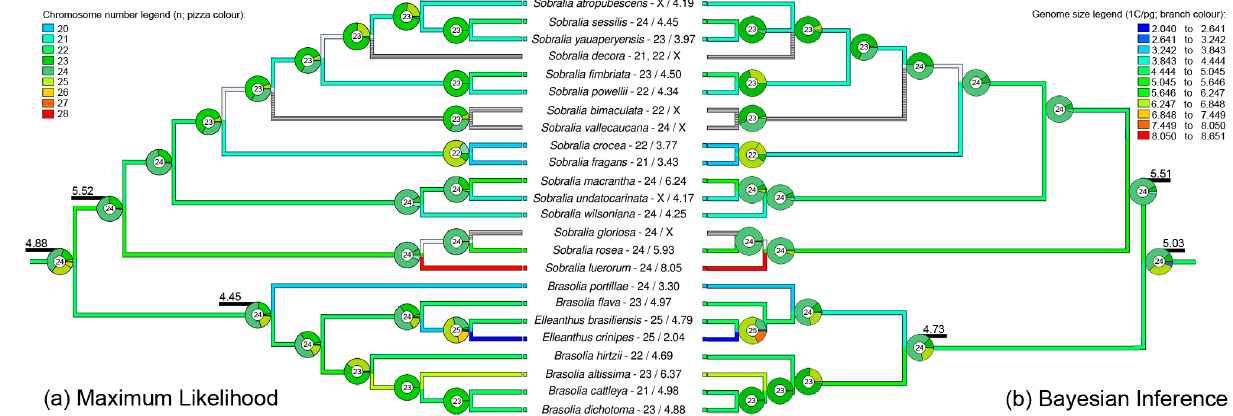
Figure 2. Maximum likelihood ( a ) and Bayesian Inference ( b ) pruned phylogenies showing the ancestral reconstruction of base chromosome number on nodes and genome size (1C-value) on branches. The ancestral genome size is indicated on the node for Brasolia , Sobralia , and the ancestral of both genera. The colour legend for the base chromosome number is on the right, and for genome size, on the left.